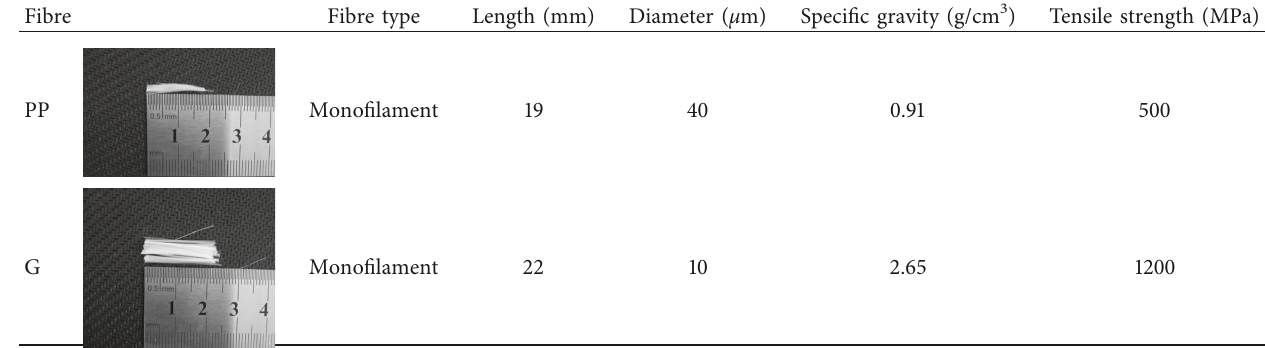
Table 2: Properties of the PP fibre and G fibre.